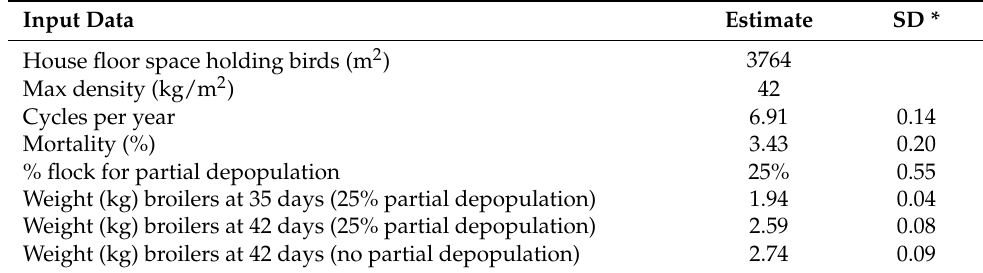
Table 1. Production parameters used in the first step of building the